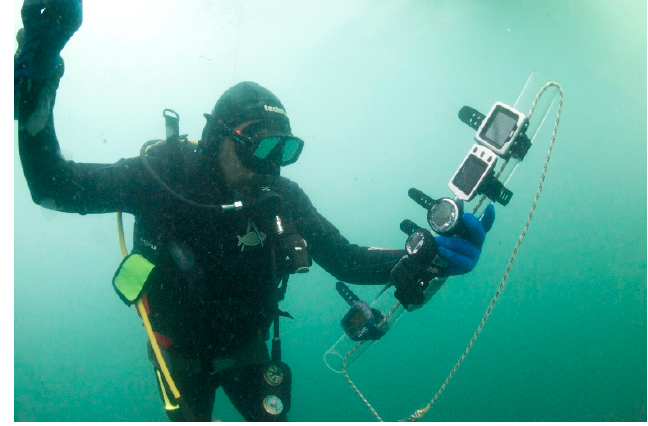
Figure 1. Open water tests with real dives (March 21, 2018).